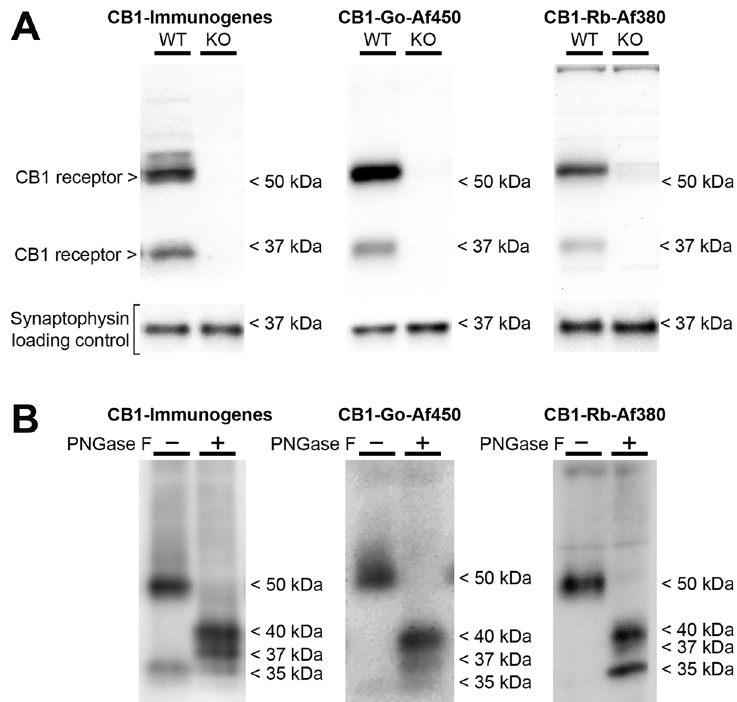
Figure 1. Immunoblot against CB1 receptor protein using CB1-Immunogenes, CB1-Go-Af450 and CB1-Rb-Af380 antibodies. ( A ) Representative Western blots carried out loading the same amount of total protein (20 µ g/lane) from synaptosomes of brain cortical tissue of wild-type (WT) and CB1-KO mice. The molecular weights depicted correspond to the signal of the standard markers. ( B ) Representative Western blots carried out loading the same amount of control and PNGase F treated frontal cortical synaptosomes (20 µ g total protein/lane). The approximate molecular masses of the immunoreactive species detected on the blot are